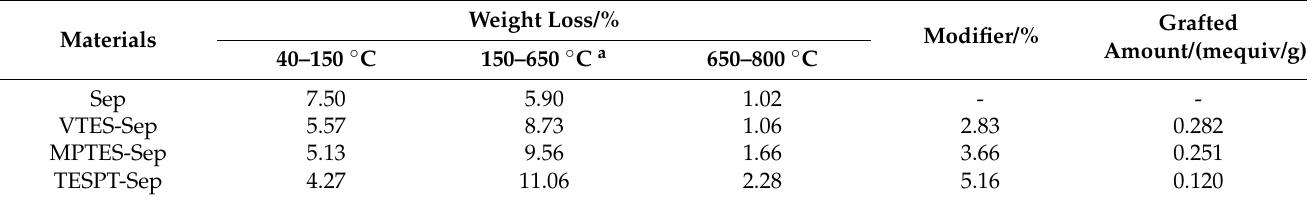
Table 3. Thermogravimetric analysis values of sepiolite and silane-modified